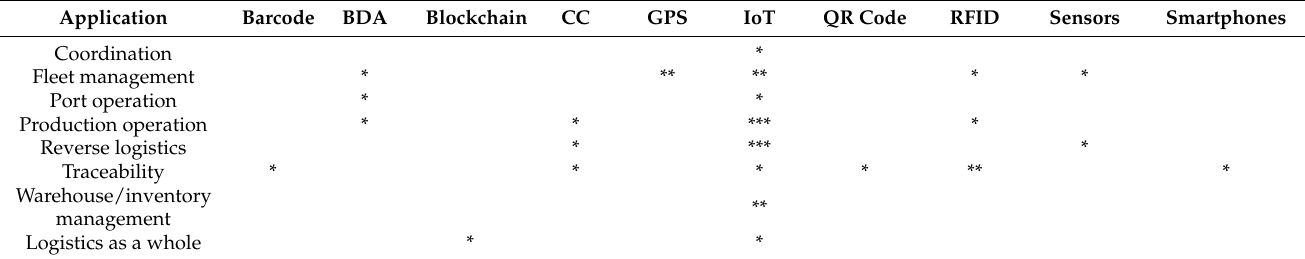
Table 8. Recommended digitalized logistics practices and their